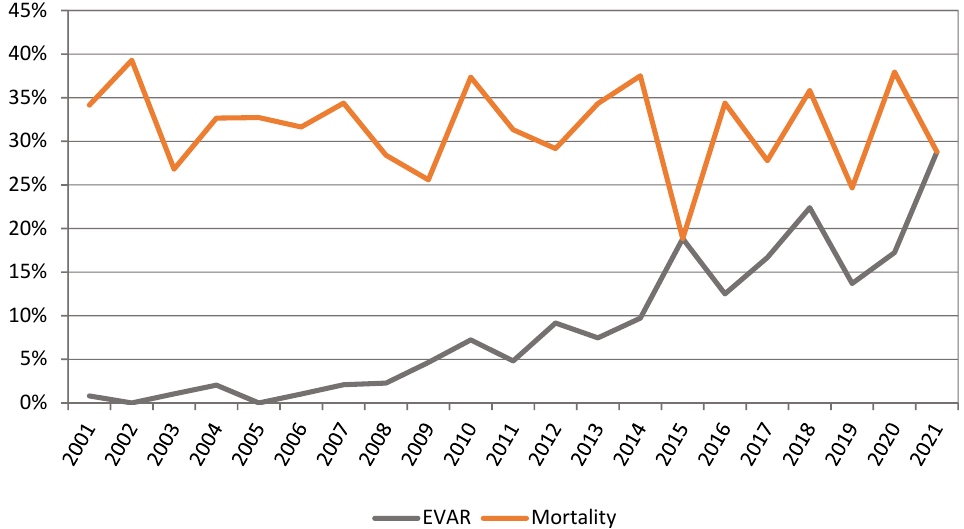
Figure 7. Ruptured AAA 30-day mortality versus proportion of EVAR used.